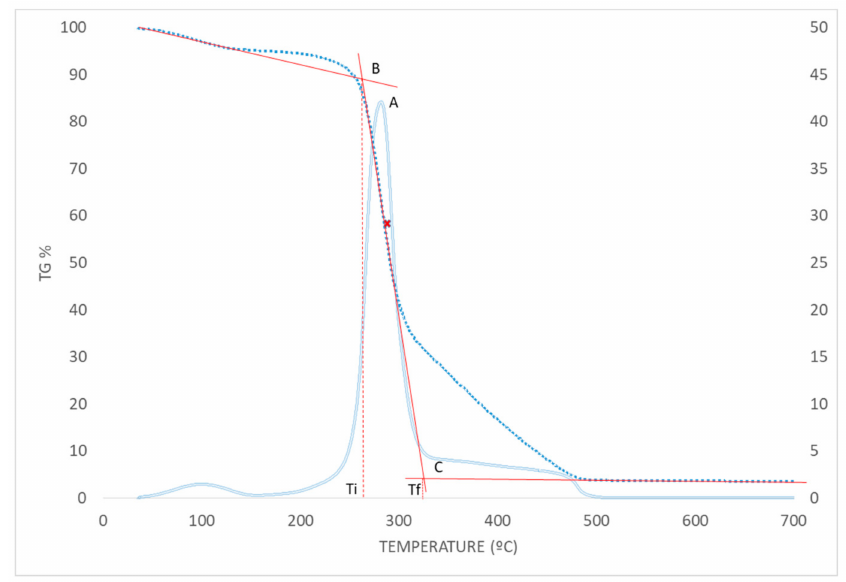
Figure 2. Tangent